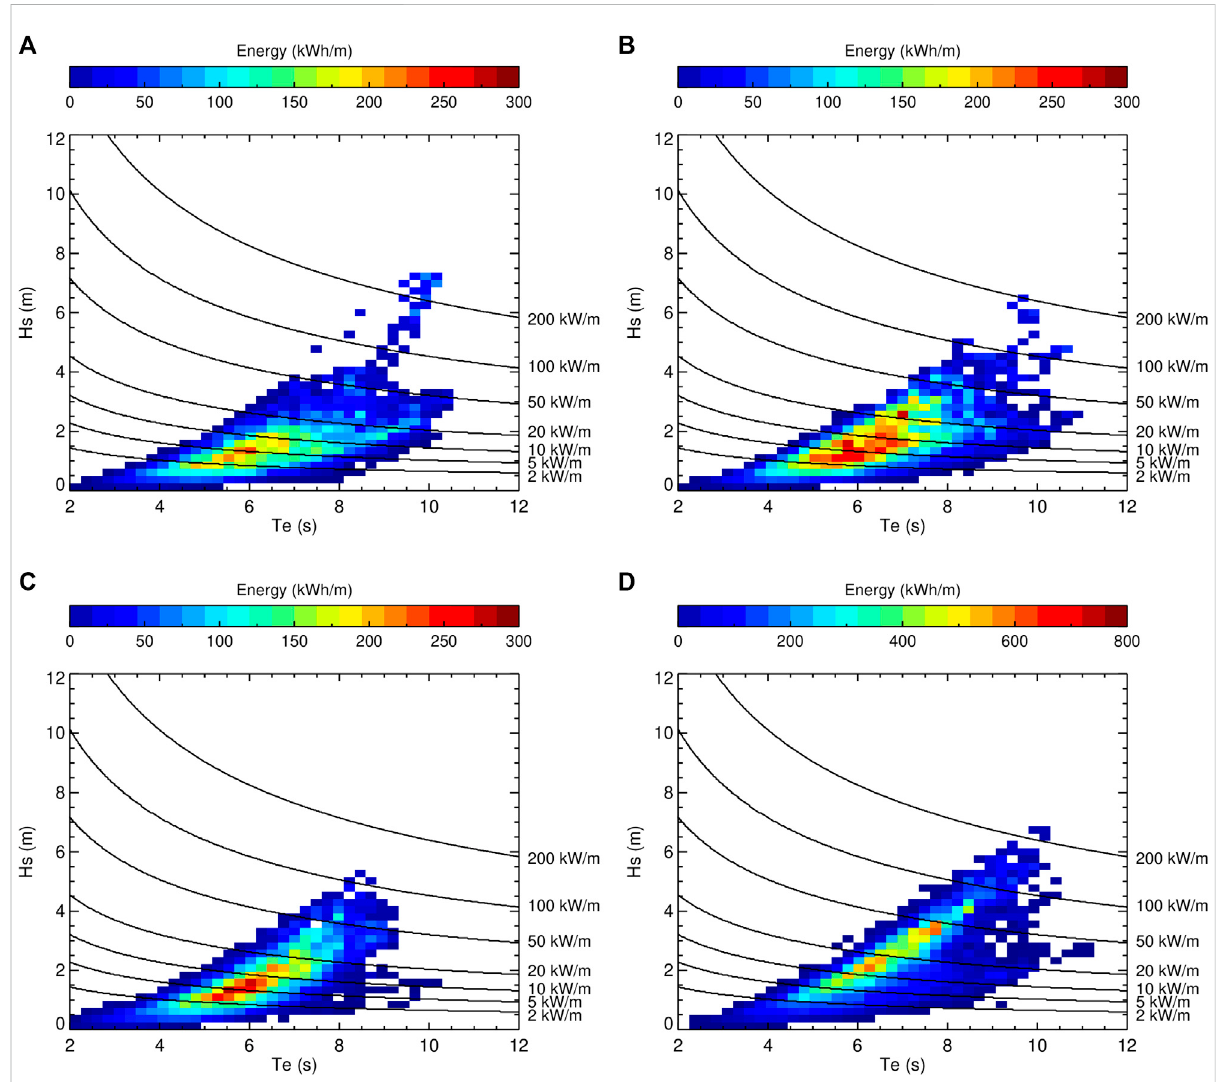
FIGURE 5 Distribution ofaverageannualwaveenergyasafunctionofsigni fi cantwaveperiodandsigni fi cantwaveheight,forsitesML-1 (A) ,ML-2 (B) ,ML- 3 (C) , ML-4 (D) of Figure 3. Dotted lines mark reference power